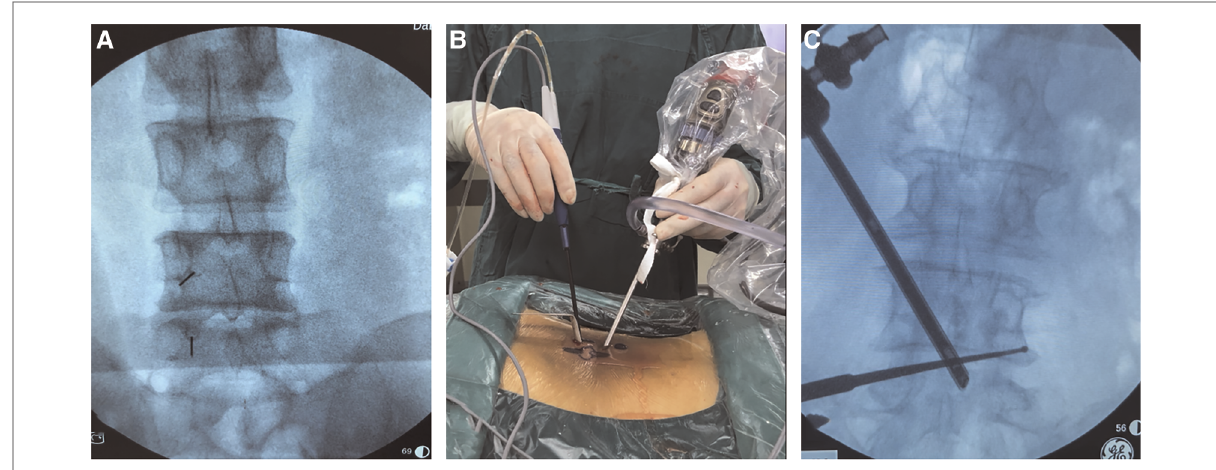
FIGURE 2 Operation and localization of unilateral biportal endoscopy. ( A ) Pictures of surgical procedures, the left hand of the surgeon is the endoscope, and the right hand is the radiofrequency probe; ( B ) 5 ml syringe needles were used for preoperative incision localization; ( C ) A nerve root probe was used to explore the foraminal region to determine the extent of decompression.